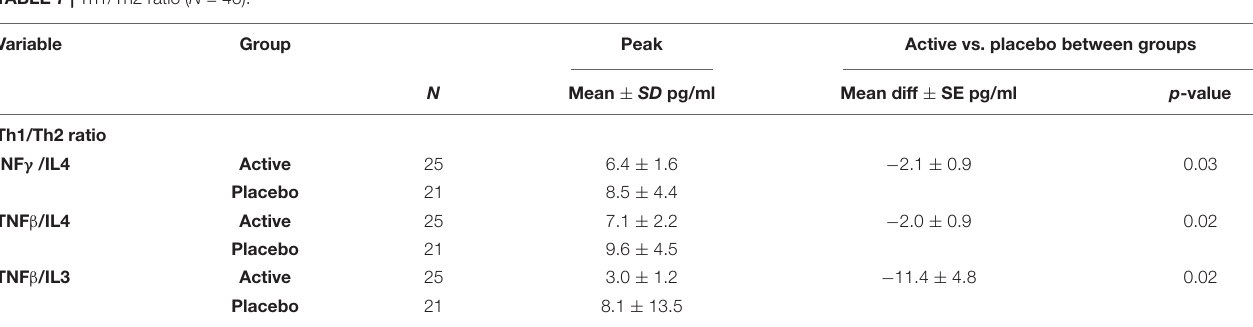
TABLE 7 | Th1/Th2 ratio ( N =